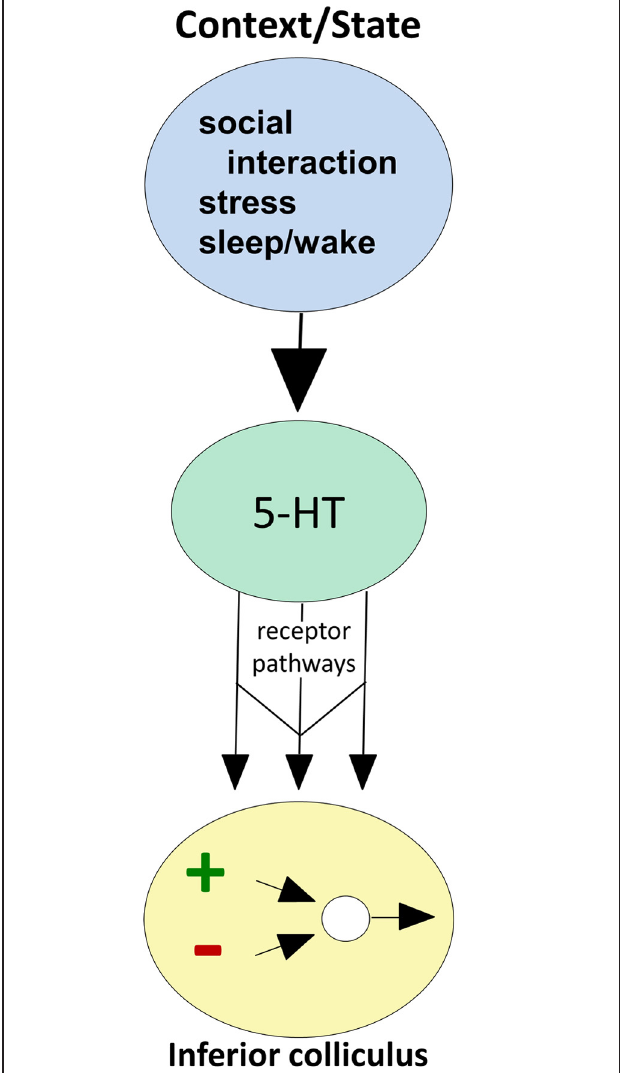
FIGURE 2 | Conceptual diagram illustrating how behavioral state modulates the function of circuitry in the IC, through serotonin receptor pathways. Behavioral factors (top oval) evoke serotonin release (middle oval), which then acts through multiple receptor types expressed by IC neurons (arrows) to influence excitatory-inhibitory circuitry (bottom